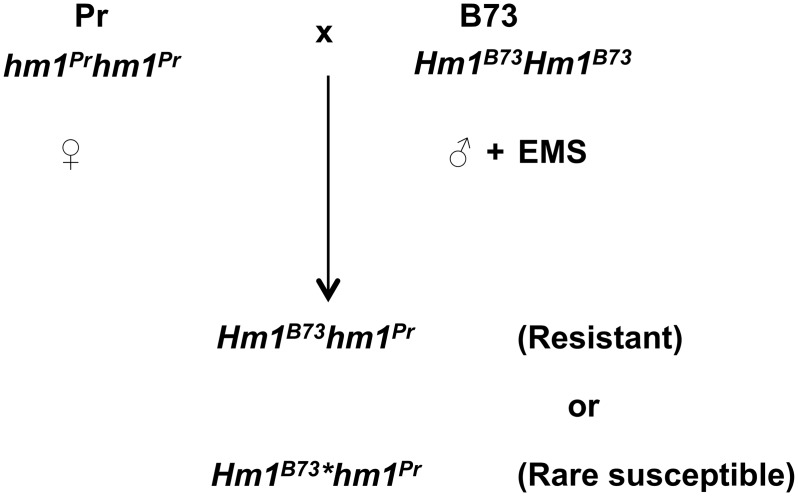
Design of the targeted EMS mutagenesis screen to generate new mutant alleles of Hm1.Pollen collected from the fully resistant inbred B73 (Hm1B73Hm1B73) was treated with ethyl methanesulfonate (EMS) and used to pollinate ears of the fully susceptible inbred Pr (hm1Prhm1Pr) in a greenhouse. The resultant M1 seeds (Hm1B73hm1Pr) were planted in the field, inoculated with CCR1, and screened for disease resistance at both the seedling stage and at maturity to identify rare susceptible mutants, designated as Hm1B73*hm1Pr. M1 mutants that were susceptible at the seedling stage but became resistant with the progression of age were considered APR. Out of about 4,500 M1 plants screened, 7 susceptible mutants were found and two became resistant at maturity.